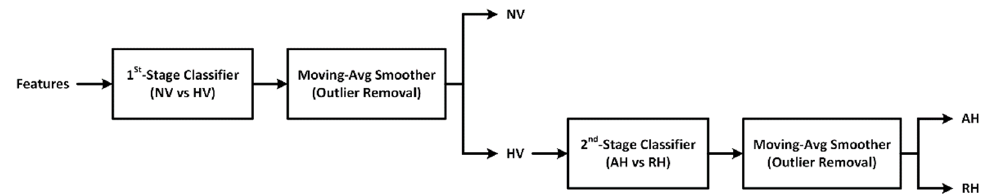
Figure 3. Machine learning (ML)-based multi-class blood volume decompensation state classification to discriminate normovolemia (NV) and hypovolemia (HV) as well as to classify hypovolemia into absolute hypovolemia (AH) and relative hypovolemia (RH).